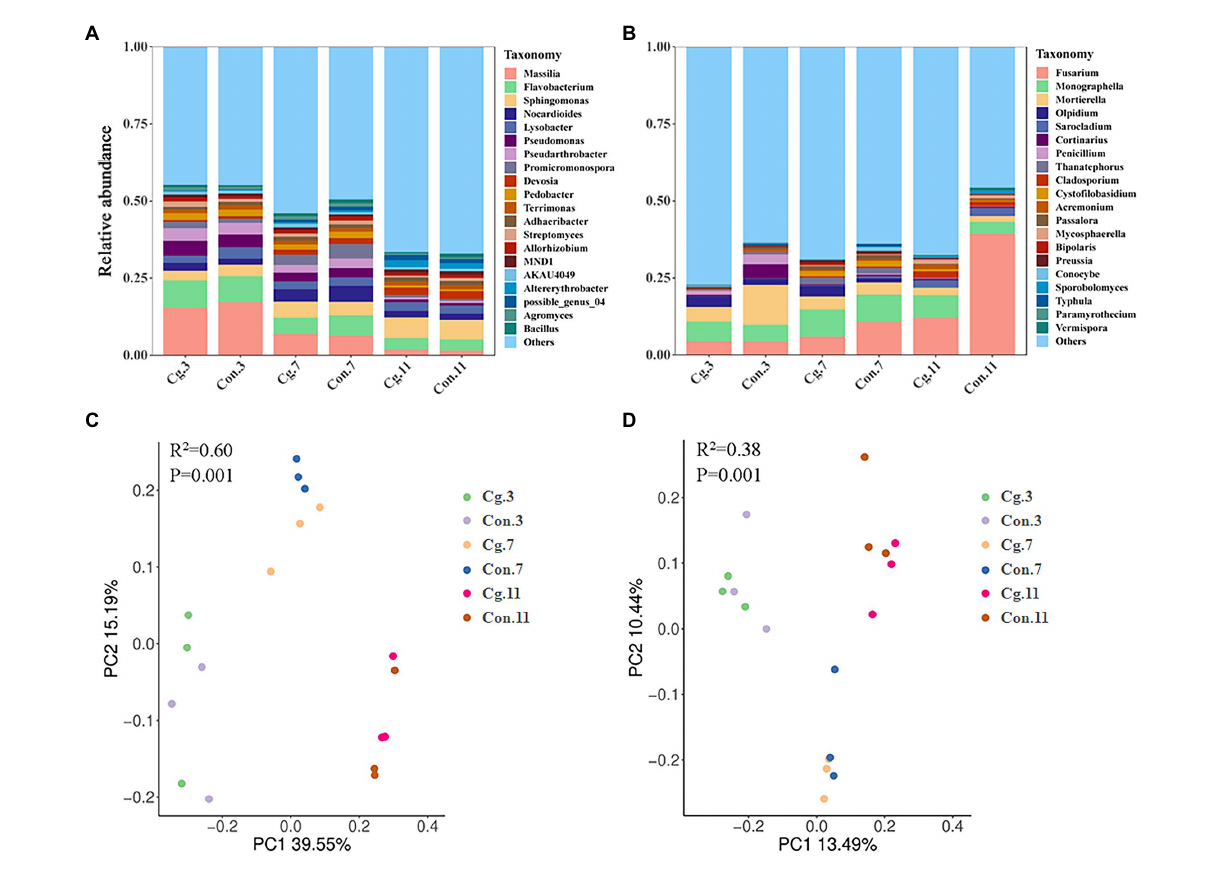
FIGURE 4 Microbial structure and beta diversity of wheat rhizosphere soil in ‘Cg’ and ‘Con’ treatments during three growth periods. (A,B) Relative abundance of bacterial (A) and fungal (B) genus in different samples. (C,D) PCoA of bacterial (C) and fungal (D) communities. Beta diversity was analyzed through ADONIS analysis based on Bray–Curtis (bacteria) and Binary-Jaccard (fungi) methods,